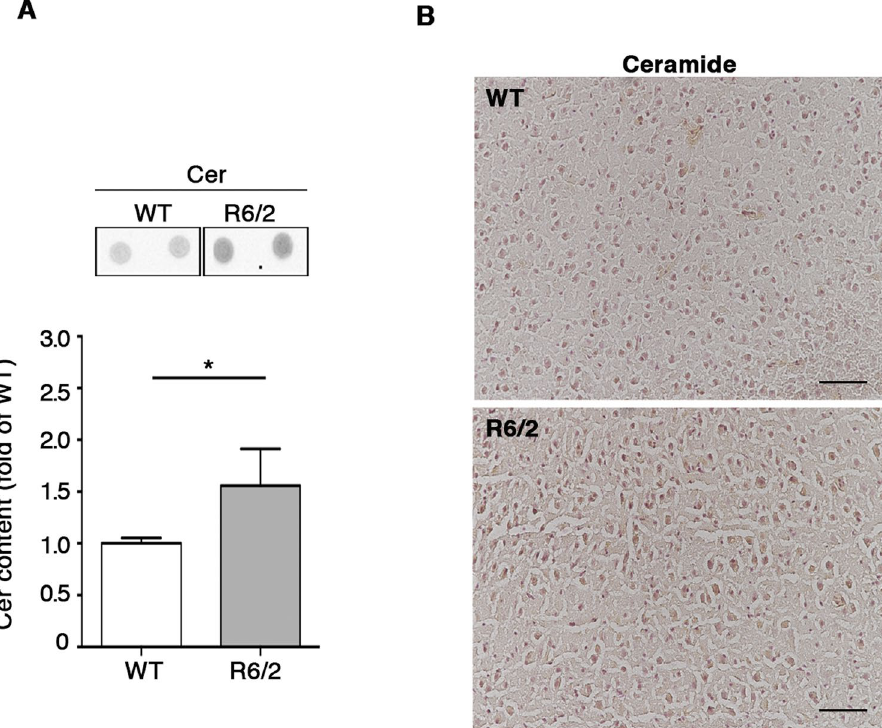
Figure 8. Levels of ceramides are increased in cortical tissue from R6/2 mice at early stages of the disease. Representative dot blotting and densitometric analysis ( A ) and immunohistochemical micrograph. Scale bar in each micrograph represents 100 µ m. ( B ) of Cer content in the cortex of early manifest (6 week old) R6/2 mice and WT littermates. Data are represented as mean ± SD. N = 5 for each group of mice. * p < 0.05 (Unpaired